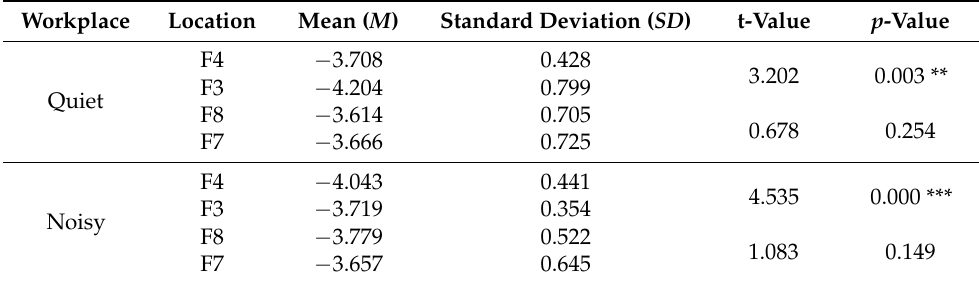
Figure 7. Average natural log alpha power recorded from the right frontal (F4 and F8) and left (F3 and F7) at quiet and noisy workplaces. Error bars indicate the standard deviation, and stars (***) signify significant differences *** p < 0.001. Table 1. Means, standard deviations, t-values, and p -values of right (F4 and F8) and left (F3 and F7) frontal hemispheres at quiet and noisy workplaces.